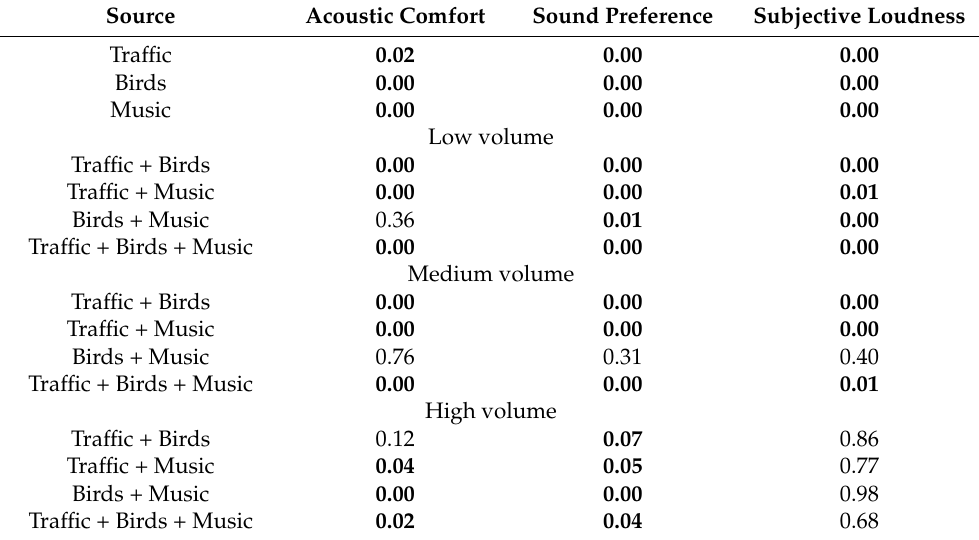
Table 2. Significance of the effects of sound type and volume level on acoustic